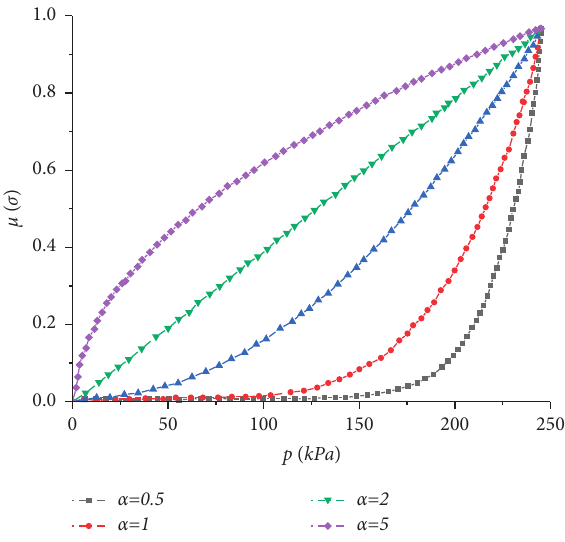
Figure 4: Evolution of plastic